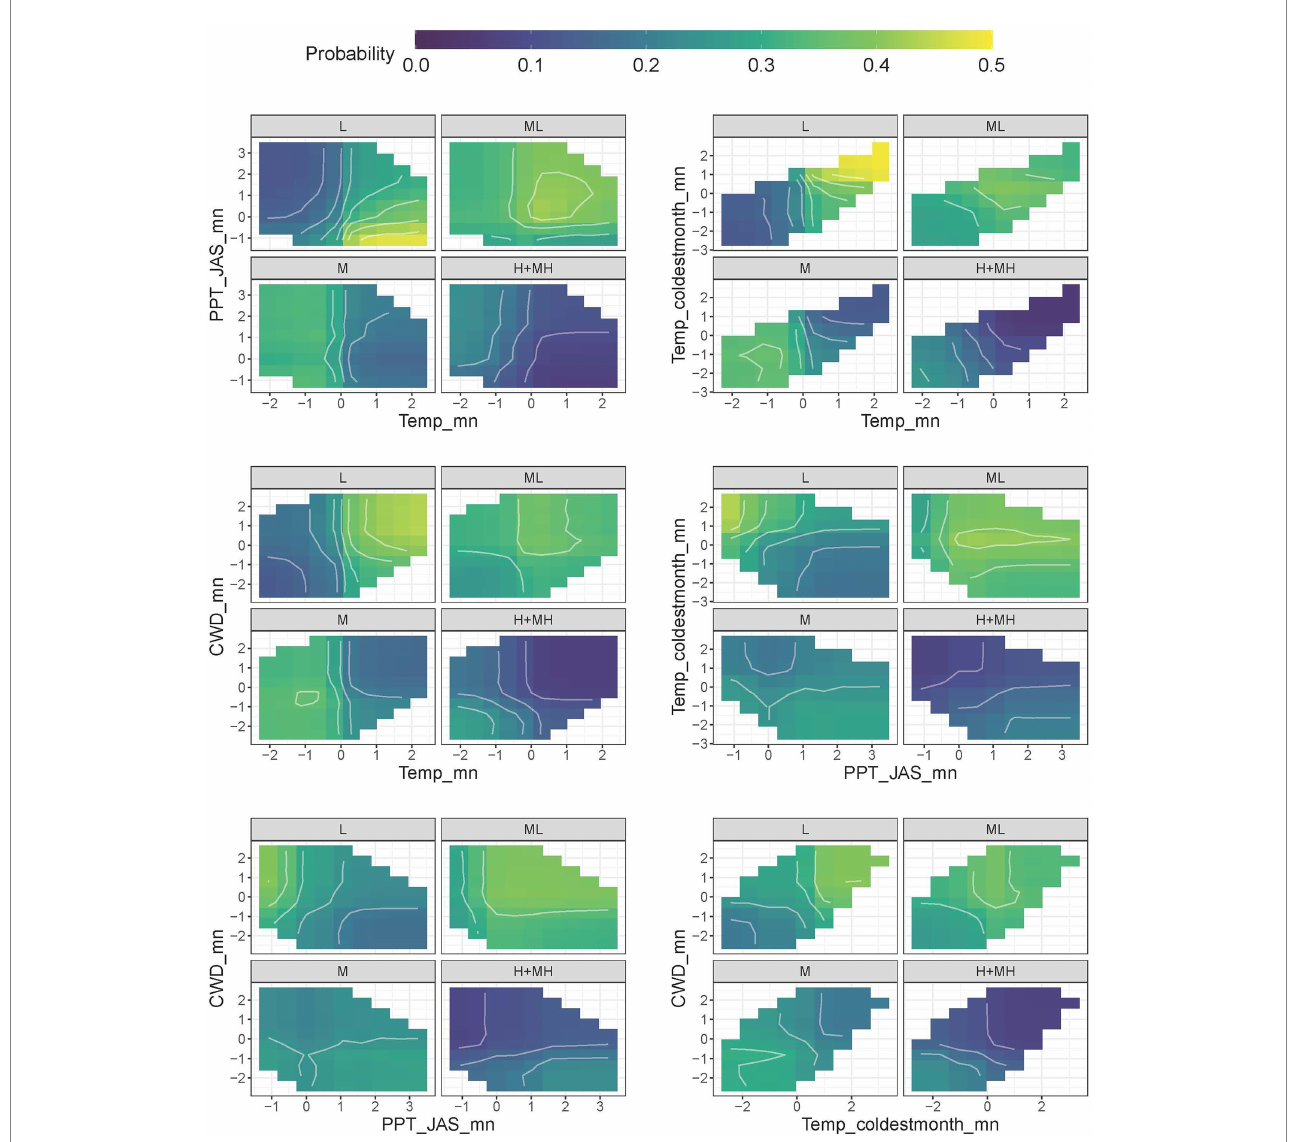
FIGURE 6 Two-way partial dependence plots (PDP) showing interactions between the four most highly ranked indicators for resilience. Lighter colors show higher probability of classification. Units for indicators are centered to mean of 0 and scaled to unit